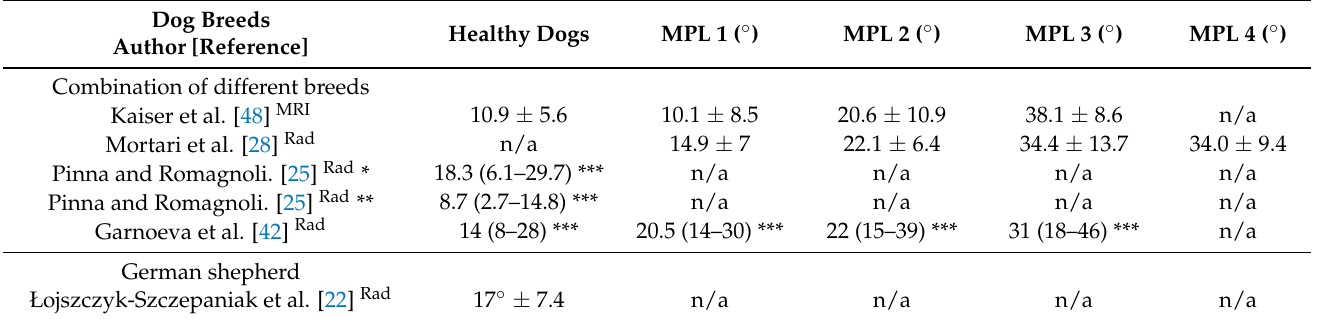
Table 10. Mean ± standard deviation of the quadriceps angle in healthy dogs and dogs with